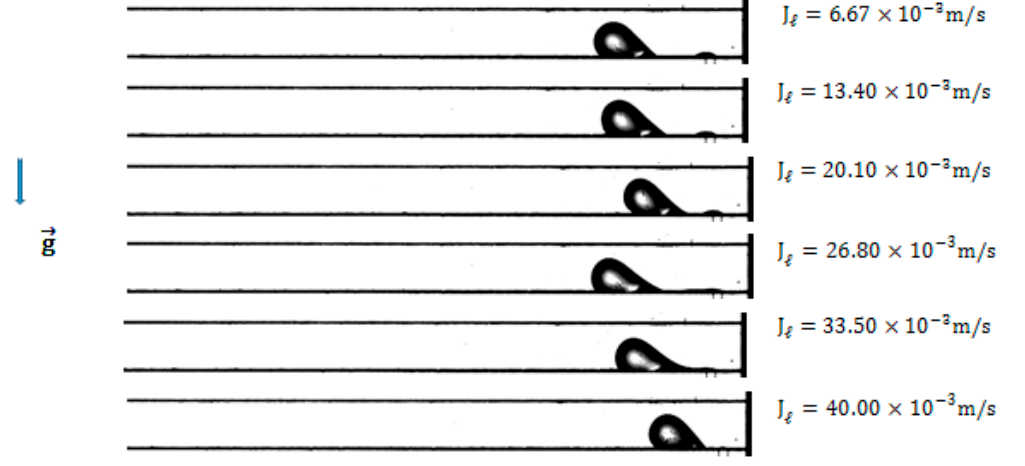
Figure 10. Droplet flow patterns for J g = 10 m / s (horizontal channel).